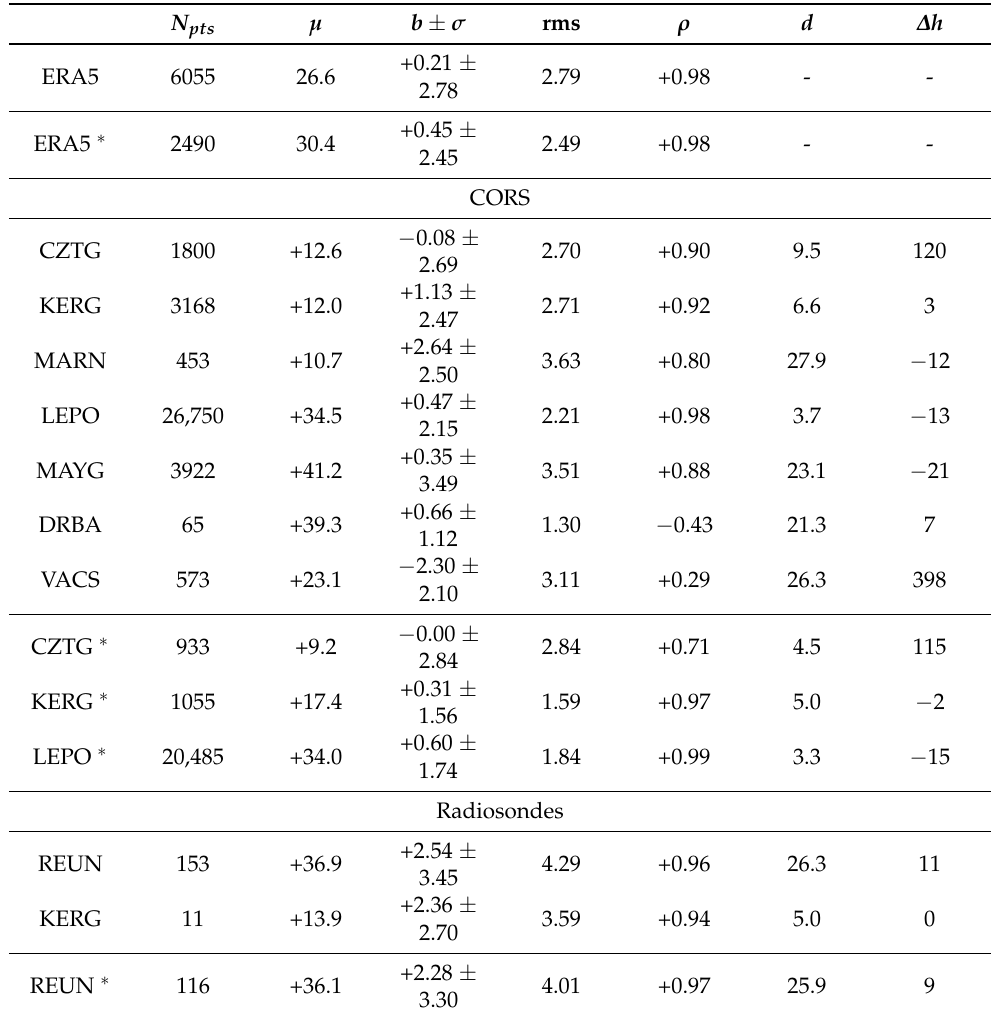
Table 3. Statistics of difference with respect to the repro solution: comparisons with IWV retrievals from ERA5, CORS and radiosoundings. N pts : number of data points; µ mean IWV (kgm − 2 ); b ± σ : bias ± standard-deviation of differences (kgm − 2 ); rms: difference root mean square (kgm − 2 ); ρ : correlation coefficient; d : mean distance between CORS or radiosonde station and the R/V (km); ∆ h : mean difference in height between CORS or radiosonde station and the R/V (m). Lines marked with a ∗ show the statistics after changing the position of the antenna on the ship. N